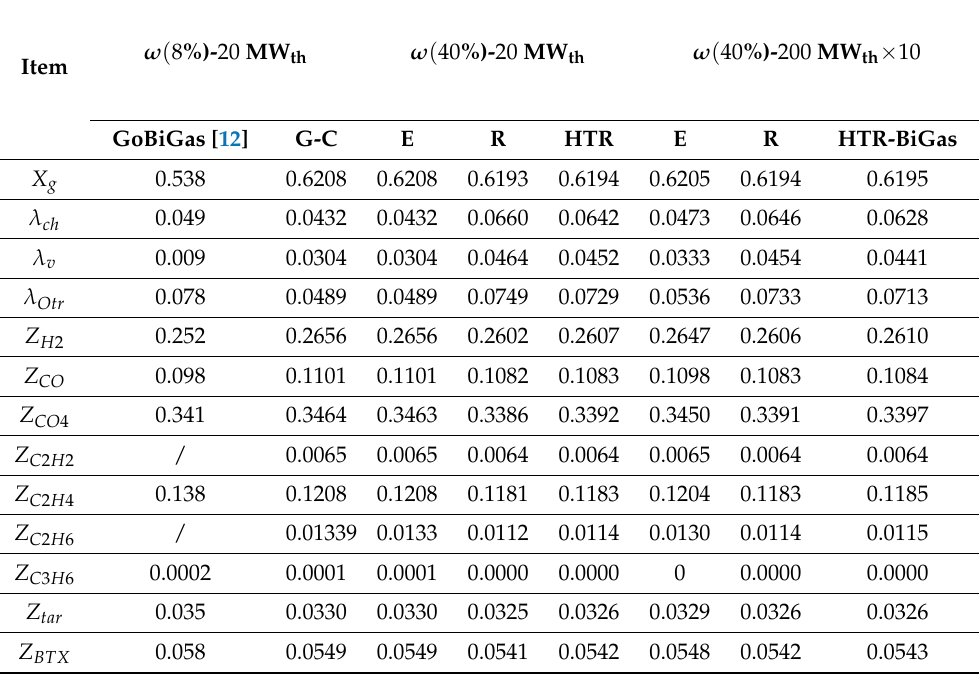
Table 4. Results of mass balances of GoBiGas, HTR-BiGas and related